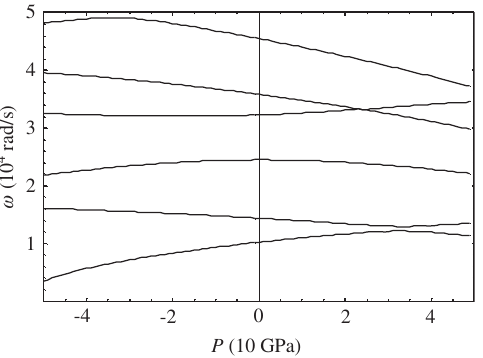
Figure 5 Frequency curves vs. initial stress P for the linearly graded cylindrical plate with η = 2 at kh =